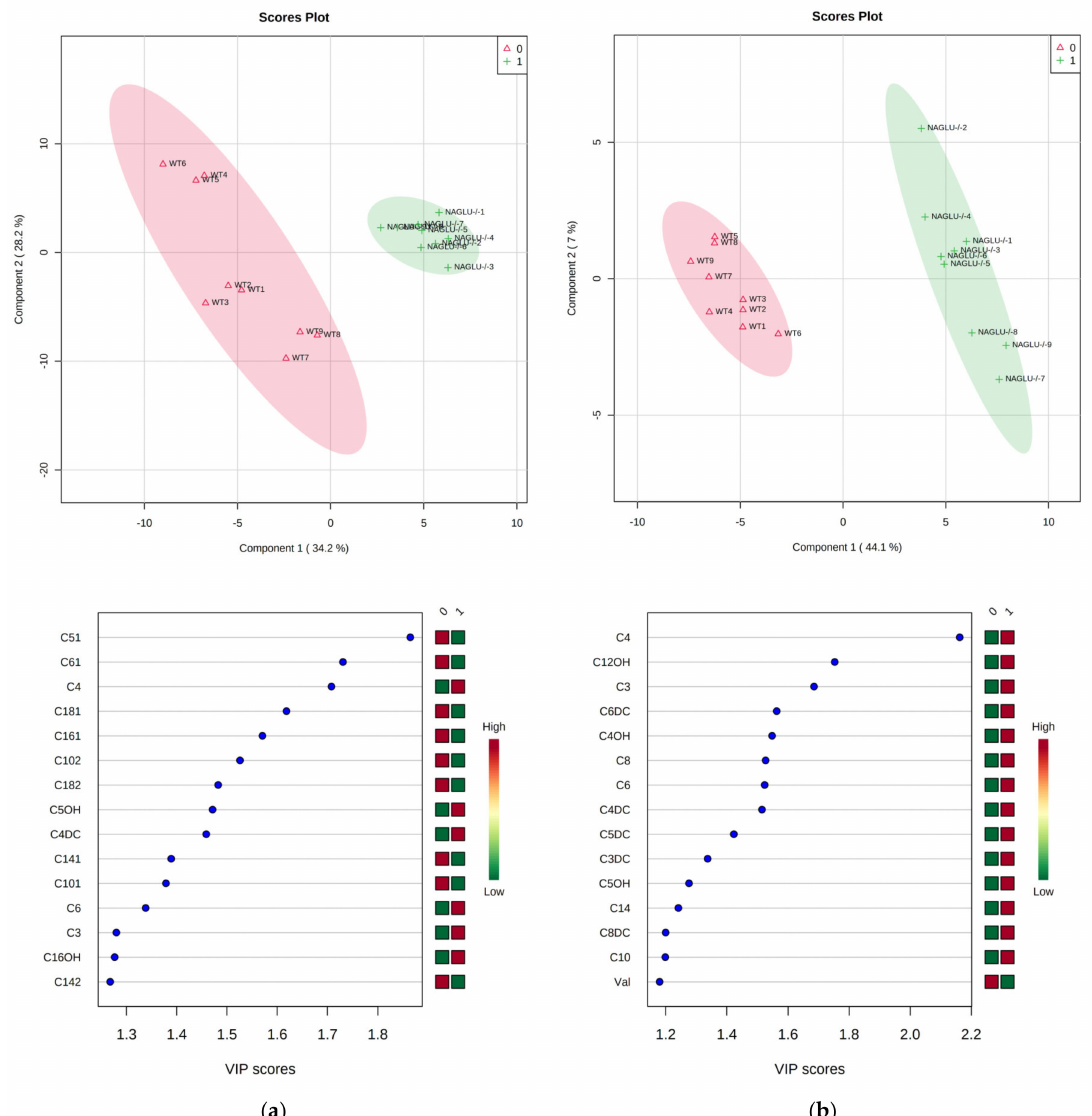
Figure 9. Partial least squares-discriminant analysis (PLS-DA) score plot of all metabolite features (top), and essential features identified by PLS-DA (bottom) according to the variable importance on projection (VIP) score in the heart ( a ) and liver ( b ) of the NAGLU − / − di ff erential metabolome. The concentrations of the metabolites from NAGLU − / − and WT heart and liver were normalized according to protein tissue contents, log(2) transformed, and Pareto scaled. The top 15 important metabolites are summarized on the left according to their VIP score value. The intensity of the colored boxes indicates the relative metabolite abundance in each group (0 WT and 1 NAGLU − / −